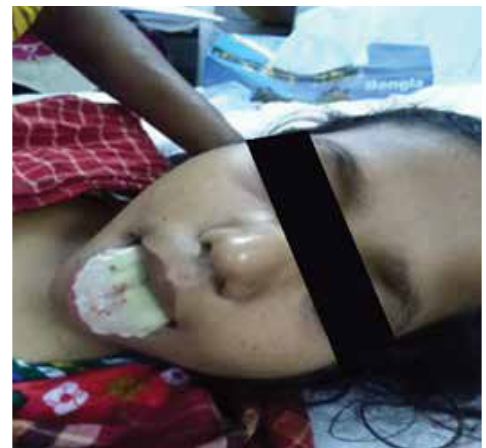
Fig 2. Coated and ulcerated tongue